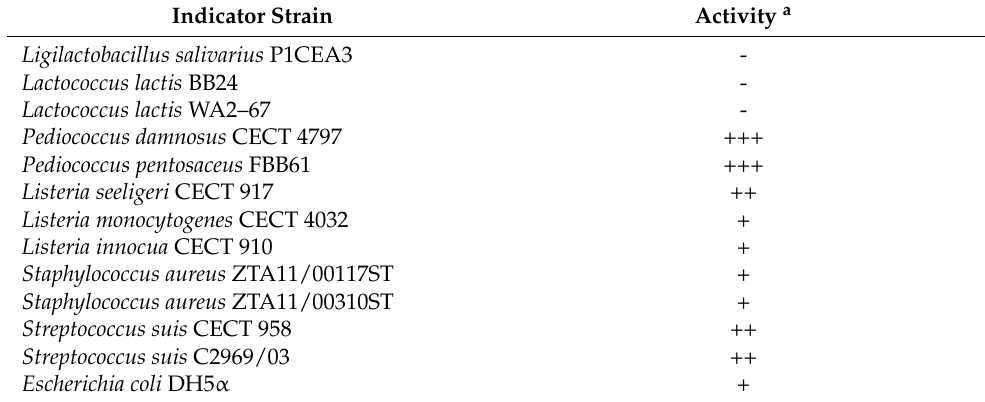
Table 1. Direct antimicrobial activity of L. salivarius P1CEA3 against different indicator strains. Indicator Strain Activity a Ligilactobacillus salivarius P1CEA3 - Lactococcus lactis BB24 - Lactococcus lactis WA2–67 - Listeria monocytogenes CECT 4032 +